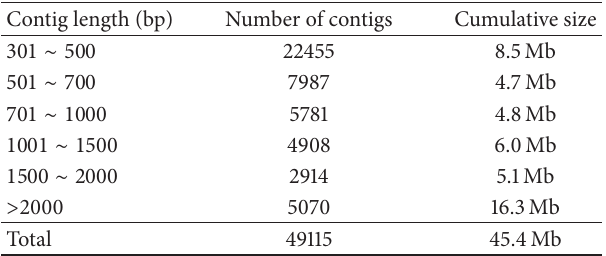
Table 2: Length distribution of 49,115 assembled